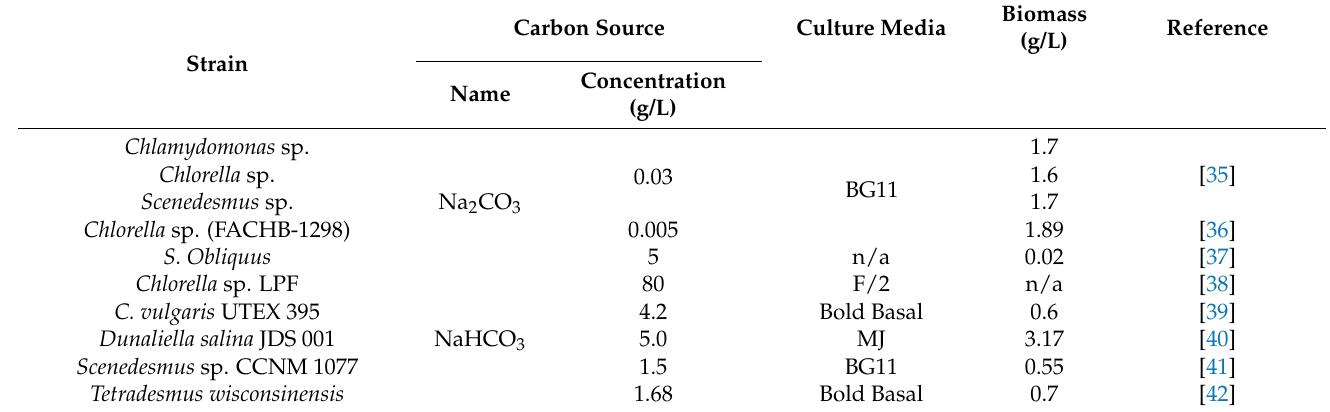
Table 2. Strains cultured with Na 2 CO 3 and NaHCO 3 as carbon